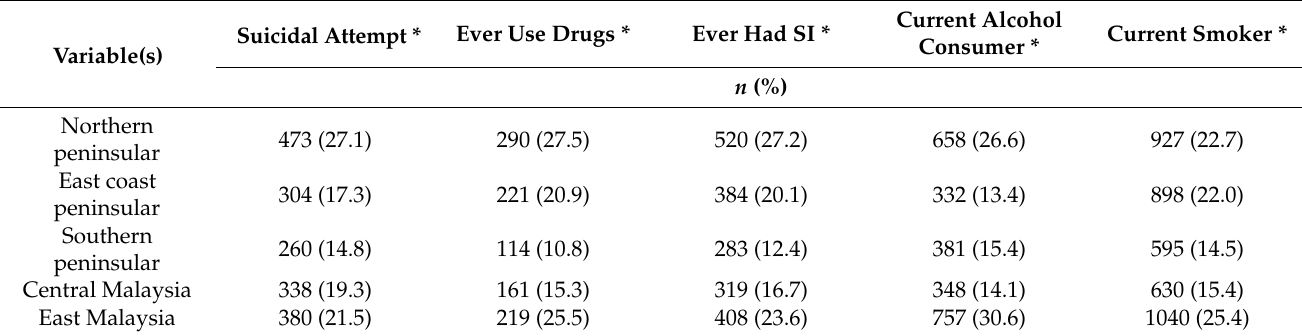
Table 1. Associations between selected high-risk behaviors and established topographical zones in Malaysia.